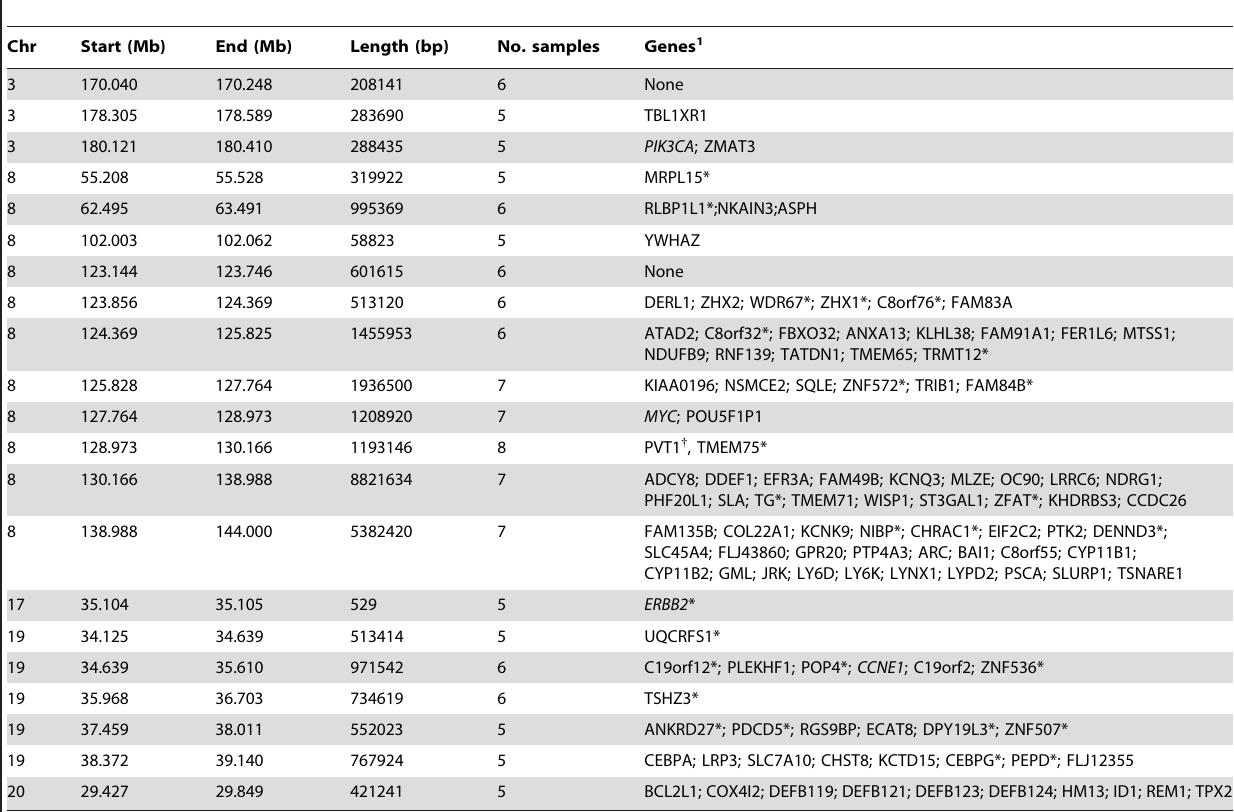
Table 5. Highly amplified